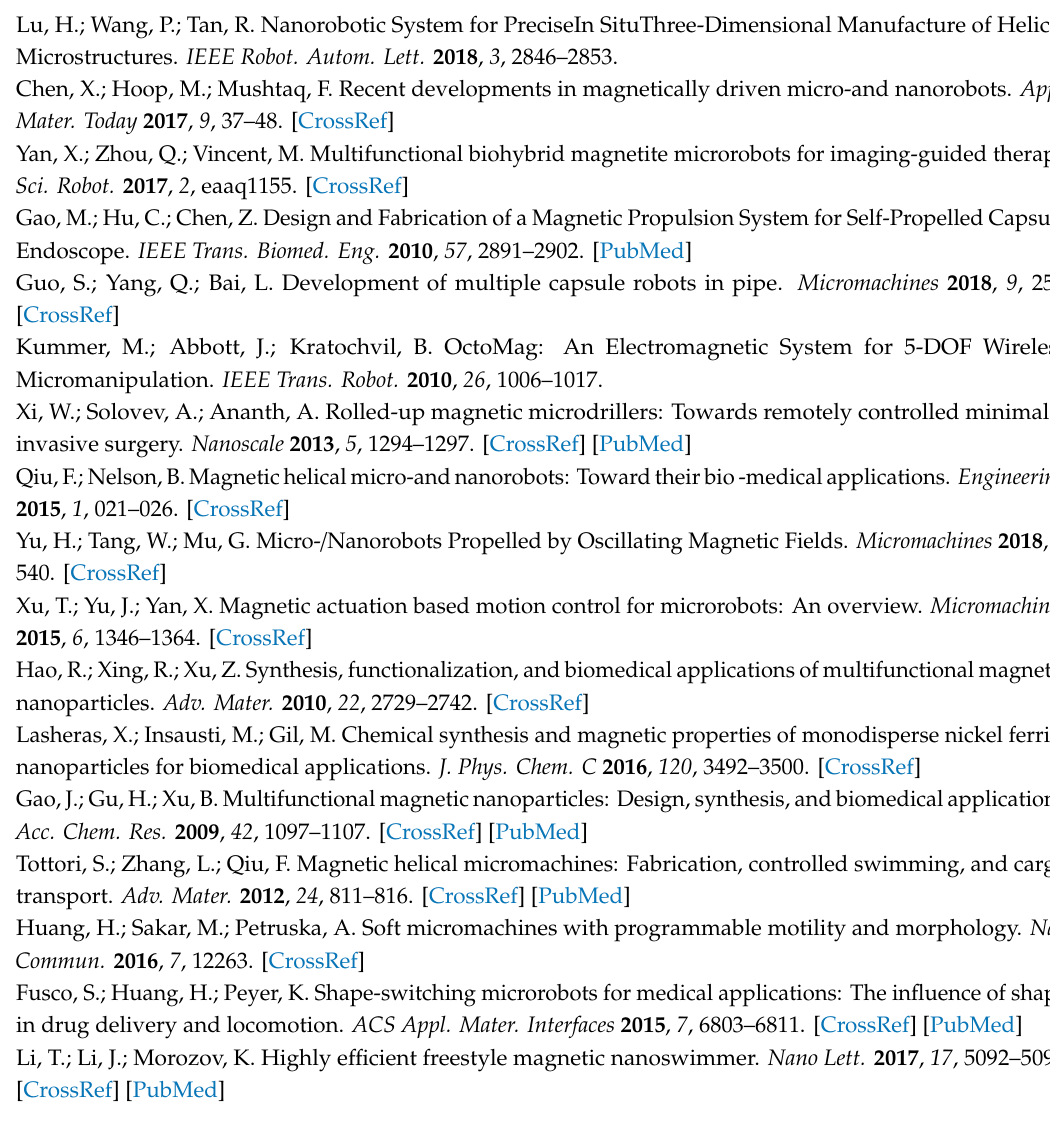
Figure S1: Relation of the micromachine magnetization to the mass ratio of nickel nanoparticles, Figure S2: Schematic of proof-of-concept experiment for drug